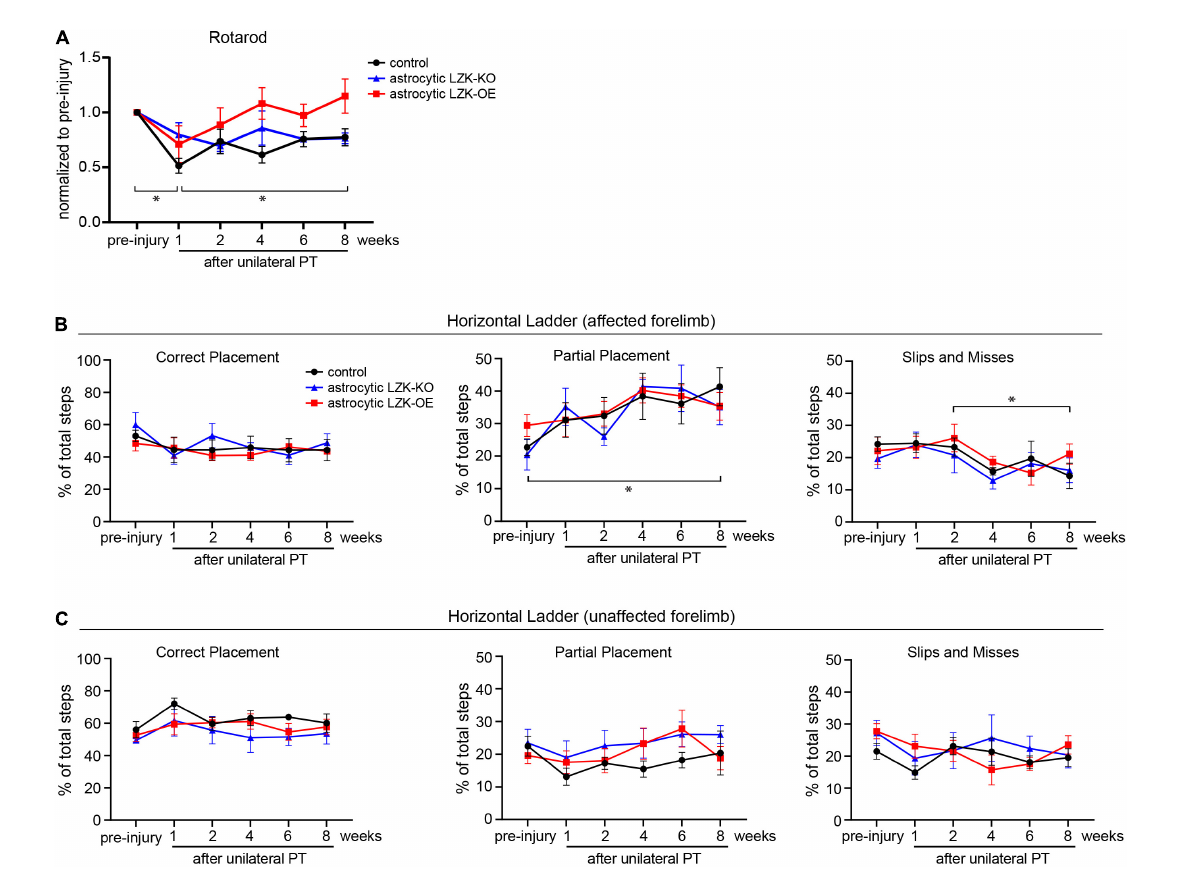
FIGURE4 LZK overexpression in astrocytes trended toward improved recovery of general motor coordination, but not skilled stepping. (A) General motor coordination and balance were assessed by rotarod in the indicated tamoxifen treated groups before and over 8 weeks after unilateral PT. Time on rotarod of each animal was normalized to its own pre-injury performance. n = 6 per group; graphing group mean with SEM. By two-way ANOVA with repeated measures, p < 0.05 for injury effect and p = 0.0501 for genotype effect. Asterisks ( ∗ ) on graph indicate p < 0.05 for post-hoc comparison of rotarod performance at the indicated time points in the control group with Bonferroni correction. (B) Skilled stepping of the affected forelimb, contralateral to PT, assessed by regular horizontal ladder before and over 8 weeks after unilateral PT. n = 6 per group; graphing group mean with SEM. Left , percentage of total steps that correctly placed on ladder rungs. Middle , percentage of total steps that partially placed on ladder rungs; two-way ANOVA with repeated measures showed p < 0.05 for injury effect only; asterisk ( ∗ ) on graph indicates p < 0.05 for post-hoc comparison between pre-injury and week 8 after unilateral PT in the control group with Bonferroni correction. Right , percentage of total steps that were slips or misses; two-way ANOVA with repeated measures showed p < 0.05 for injury effect only; asterisk ( ∗ ) on graph indicates p < 0.05 for post-hoc comparison between weeks 2 and 8 after unilateral PT in the control group with Bonferroni correction. (C) Skilled stepping of the unaffected forelimb, ipsilateral to PT, assessed by regular horizontal ladder as in panel (B)